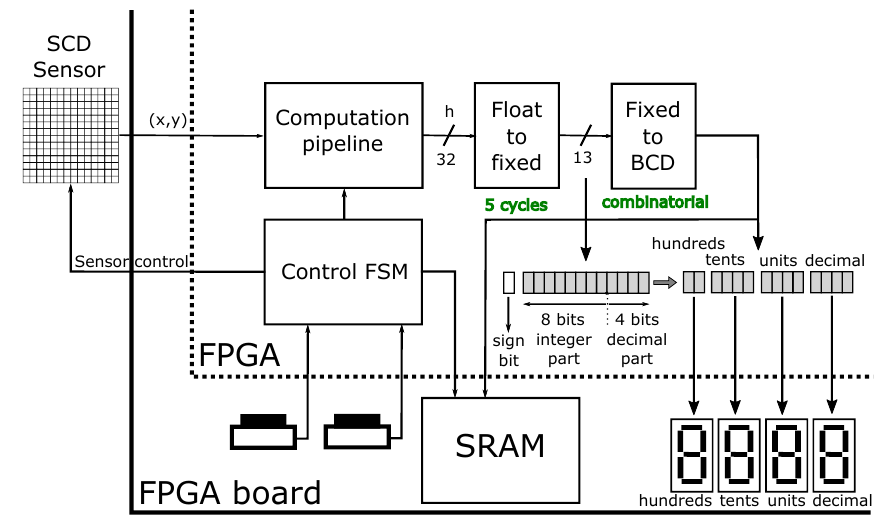
Figure 7. Display and memory stages.